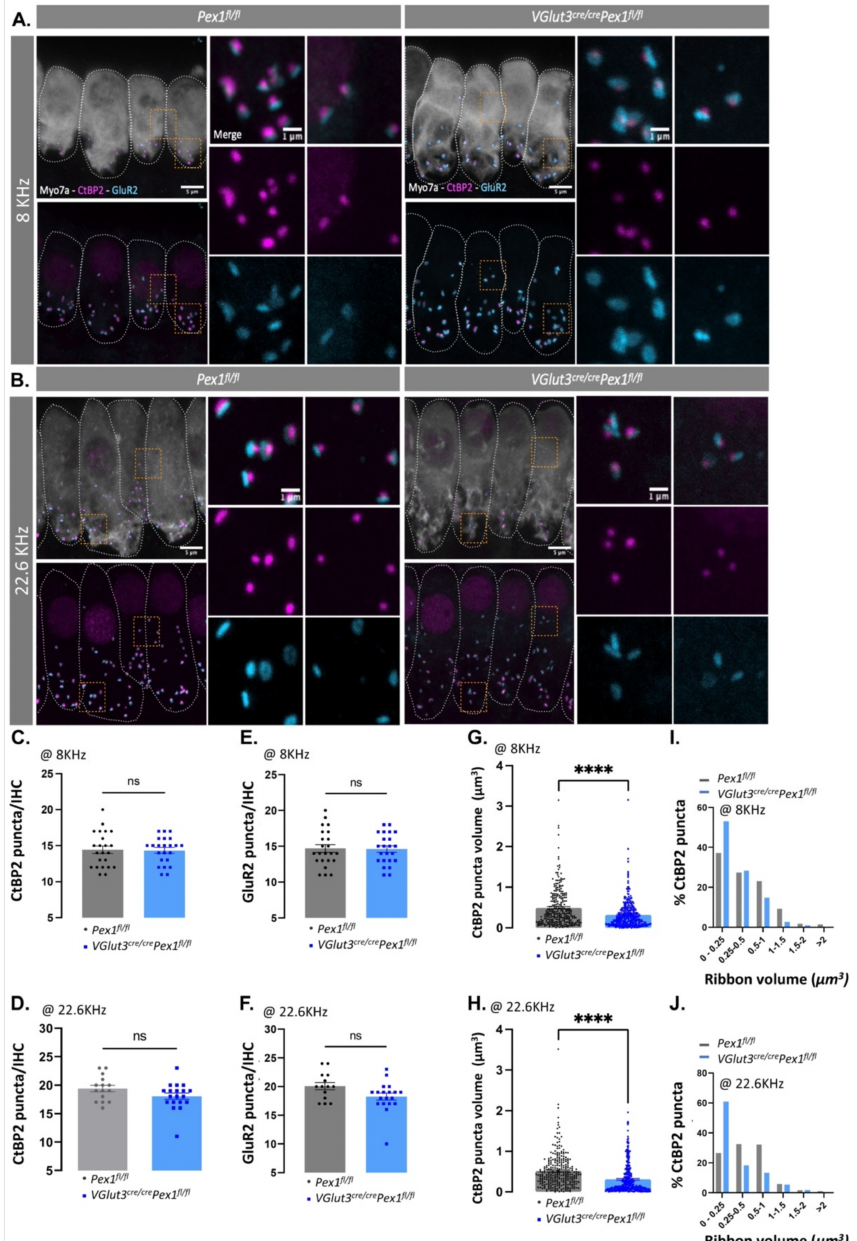
Figure 5. Pex1 defect leads to smaller ribbon synapses. ( A , B ) Confocal images of inner hair